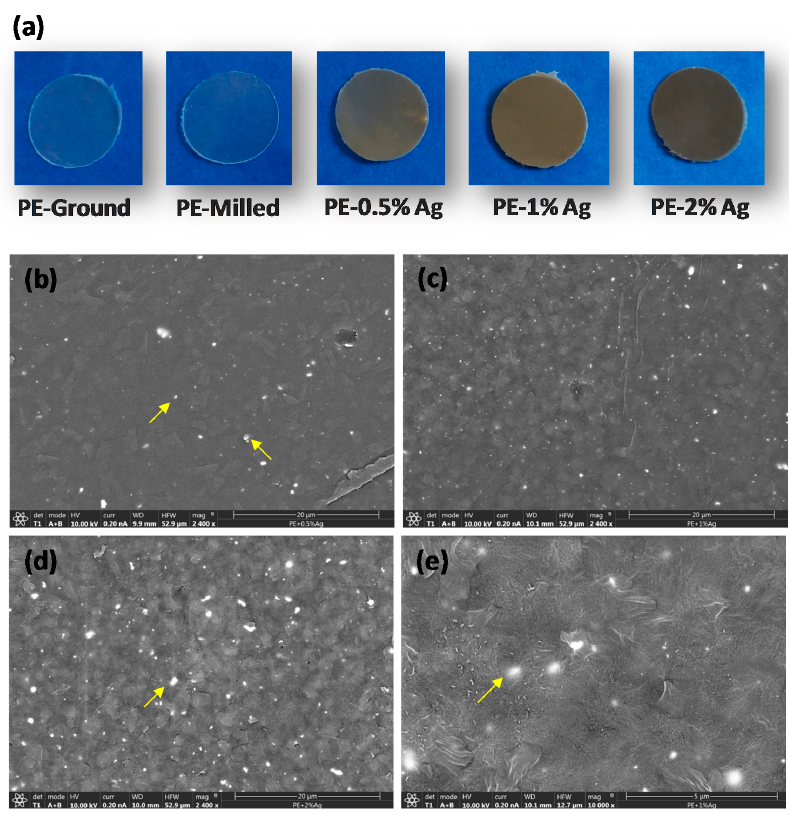
Figure 1. ( a ) Visual appearance of the samples cut in circular disks with a diameter of 1 cm; SEM micrographs obtained with BSE detector for: ( b ) PE-0.5% Ag; ( c ) PE-1% Ag; ( d ) PE-2% Ag and ( e ) magnification of ( c ) to show the size of the domains (where PE stands for polyethylene).